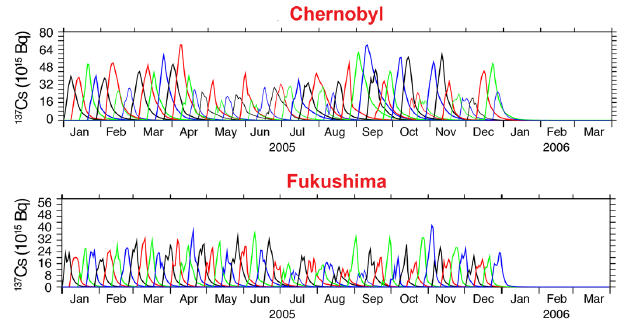
Fig. 7. Atmospheric load of 137 Cs by applying the emissions of Chernobyl (85pBq) each week. The simulations were performed for the locations of Chernobyl and Fukushima, applying the same source